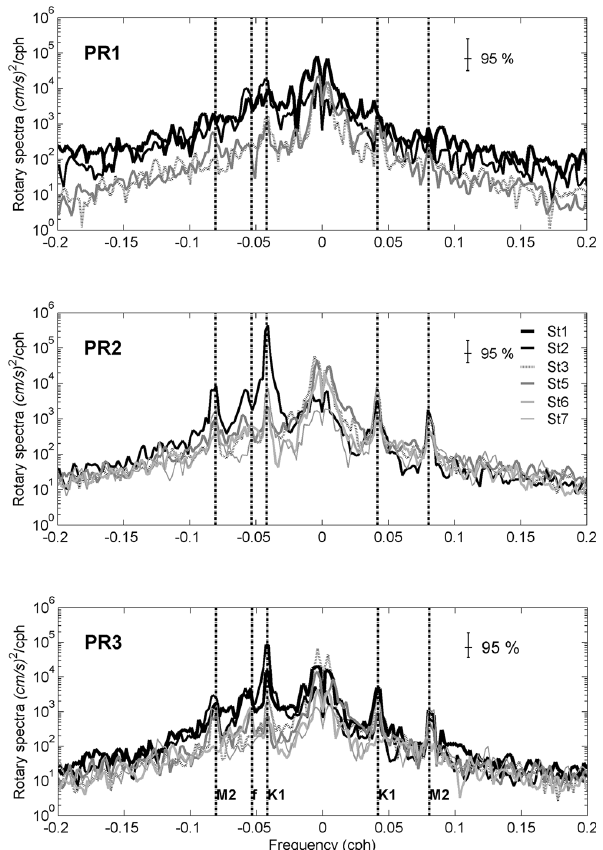
Fig. 5. Rotary spectral analysis in the near-bottom layer along the Otranto section for the three time intervals PR1, PR2, and PR3 from OTRANTO/OGEX project. The 95% confidence level is indicated. f is the Coriolis parameter divided by 2 π